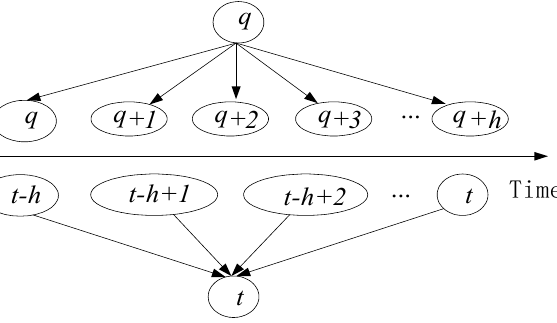
Figure 1. The evolution of the outputs of wind and photovoltaic power over time. Let f q , t be the forecast made at time q for time t ( t = q + 1, q + 2, . . . , q + h ) , and f t be the observed value at time t . The forecasting error e q , t estimated at time q is obtained from the difference between f q , t and f t :